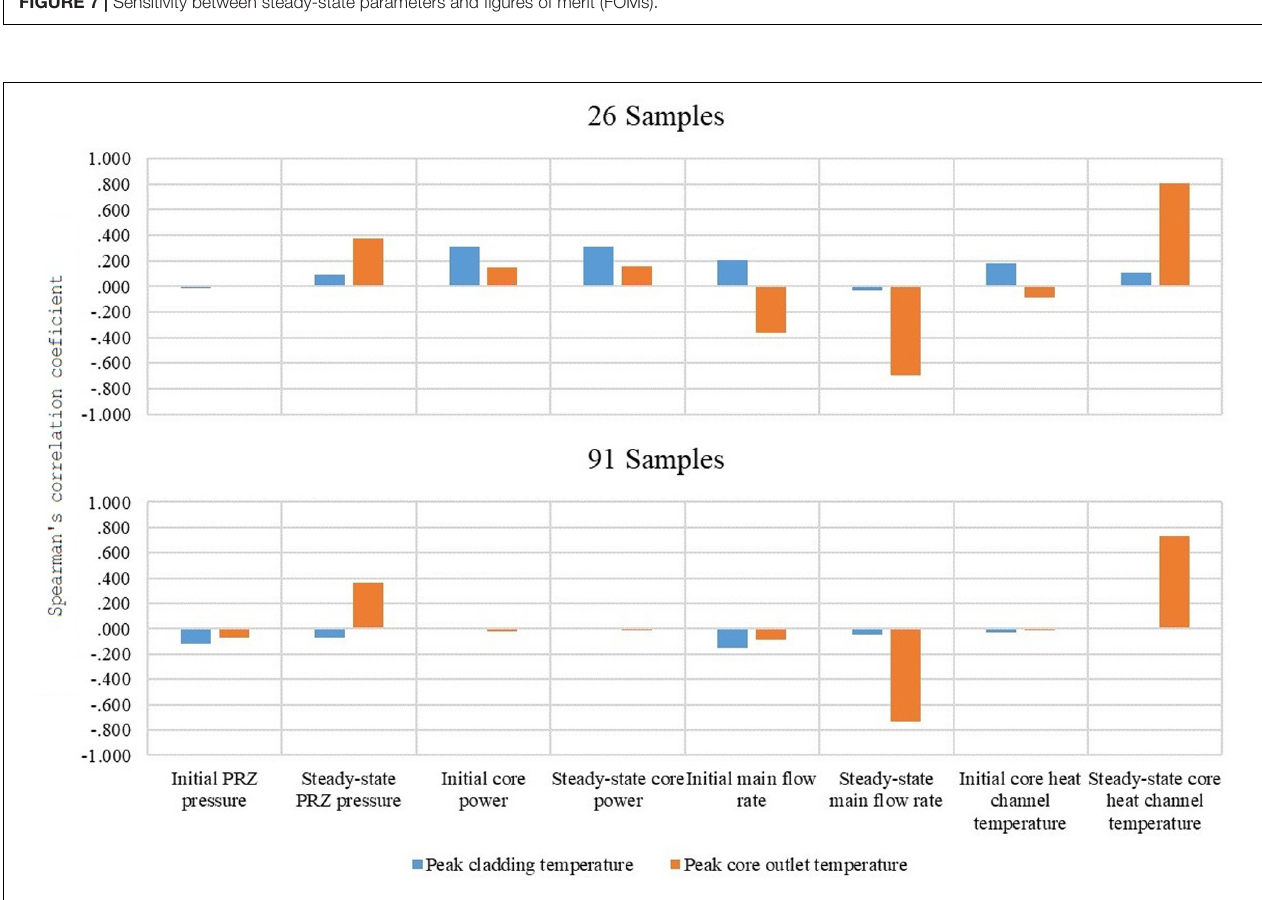
FIGURE 8 | The comparison between the initial parameters and the steady-state parameters with the output figures of merit (FOMs).